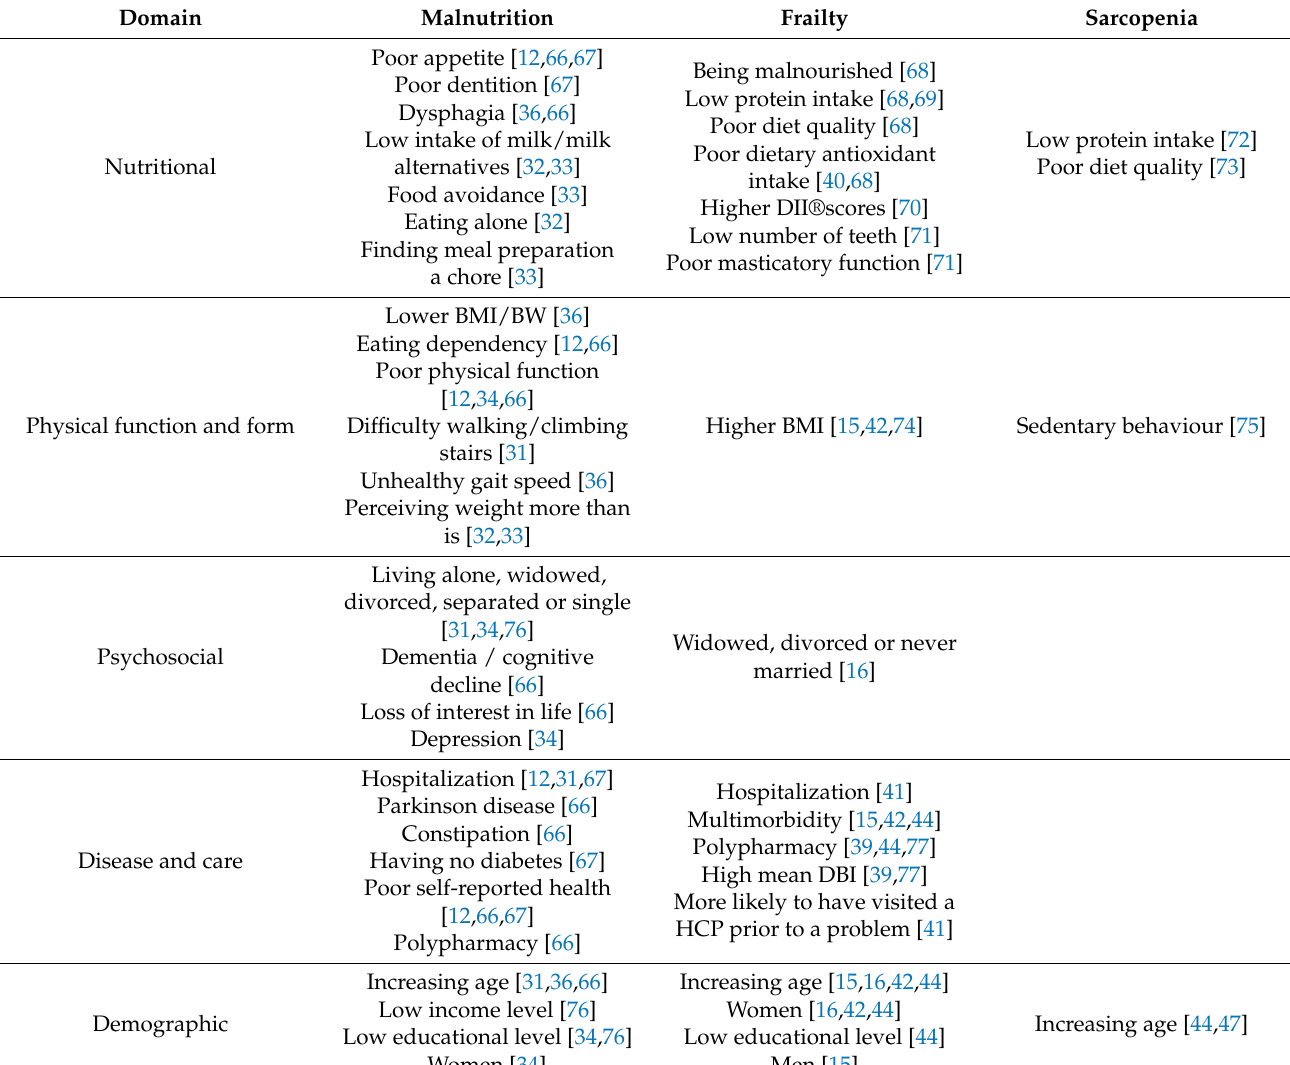
Table 1. Risk factors for malnutrition, frailty and sarcopenia in older community-dwelling